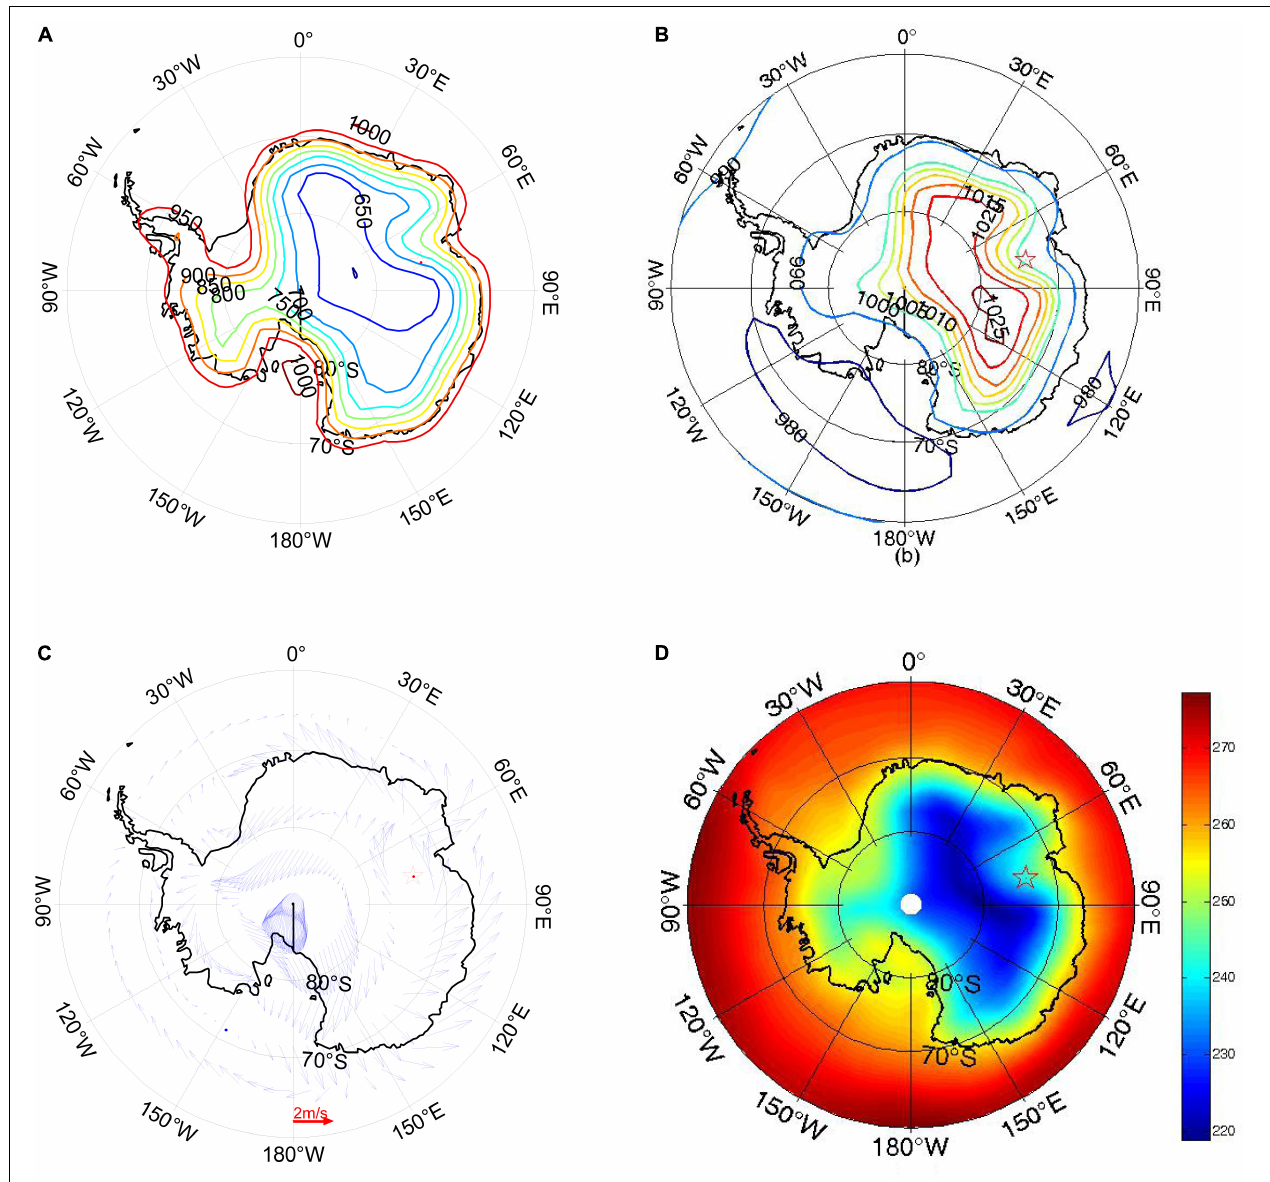
FIGURE 12 | (A) Spatial patterns of the averaged surface pressure (Unit: hpa), (B) mean sea level pressure (Unit: hpa), (C) 10 m wind field, and (D) 2 m air temperature (Unit: K). The asterisk denotes the site of Taishan Station. All data are derived from the National Center for Environmental Prediction (NCEP)-DOE (Department of Energy) Reanalysis II dataset